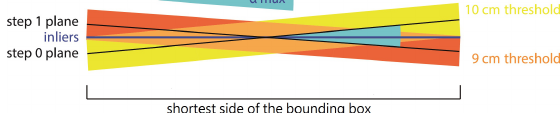
Figure 3: The worst-case scenario of the first two steps deter- minates the maximum angle formed by the planes of two conse- quents steps.